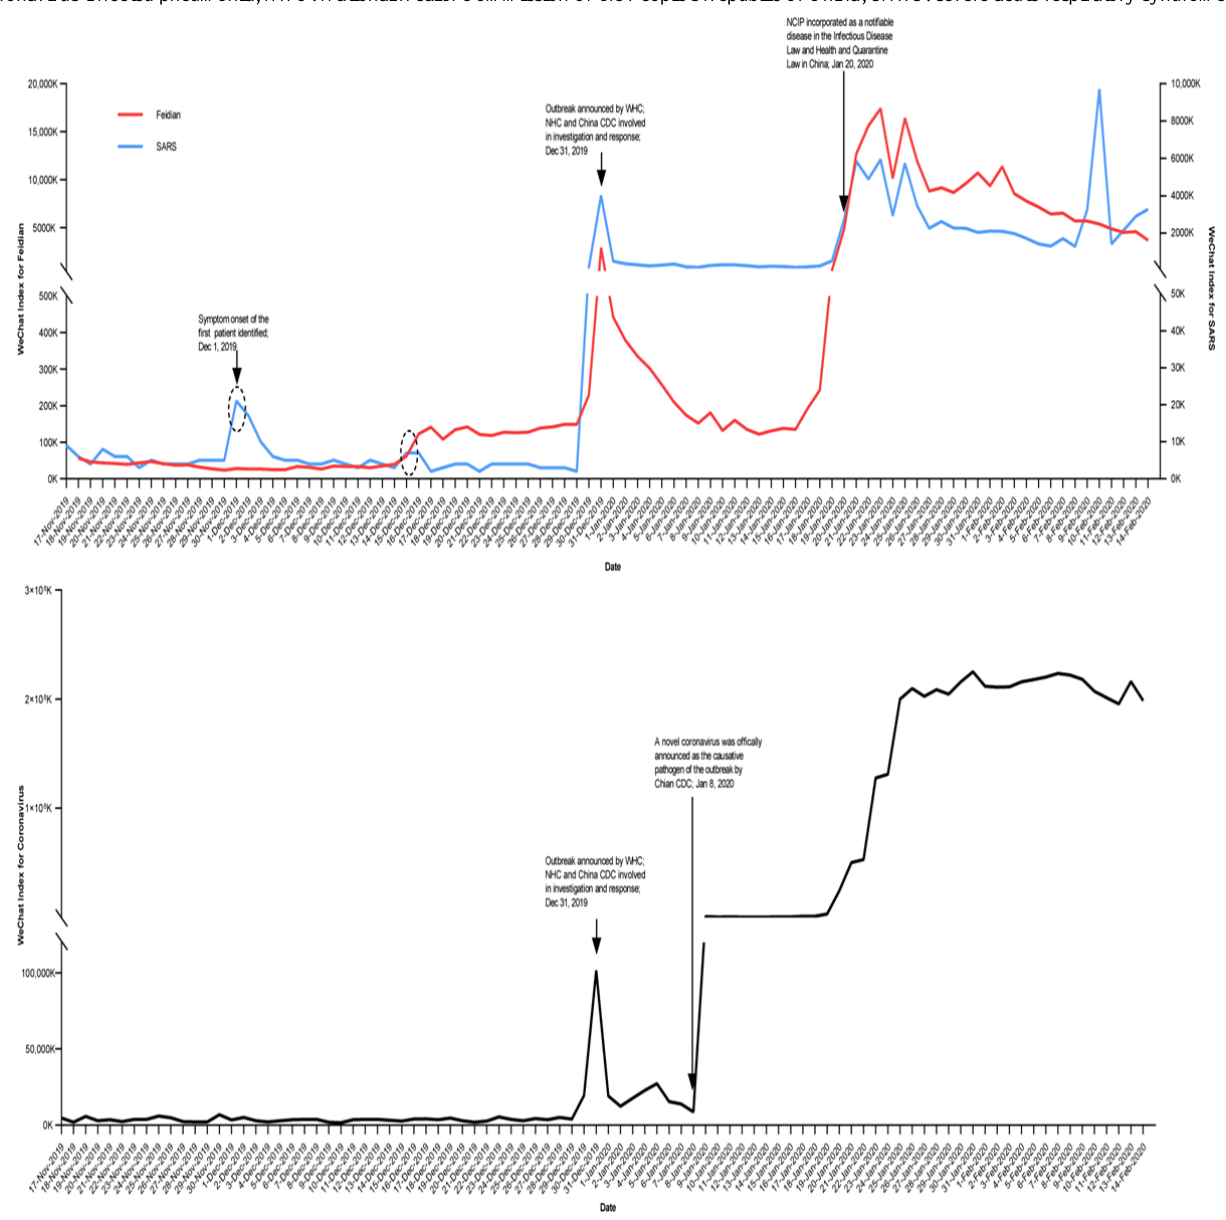
Figure 1. WeChat Index results for the words Feidian, SARS, and coronavirus. The index results for “Feidian” began to rise on December 15, 2019 (dashed circle), persisted at relatively high levels until December 29, 2019, and rose rapidly on December 30, 2019, with a peak on December 31, 2019. The index results for “SARS” were atypical during the first three days of December, with a peak on December 1, 2019 (dashed circle). The index results for “coronavirus” began to rise on December 30, 2019, with a peak on December 31, 2019, followed by another increase on January 9, 2020. China CDC: Chinese Centers for Disease Control and Prevention; Feidian: Chinese abbreviation of severe acute respiratory syndrome; NCIP: